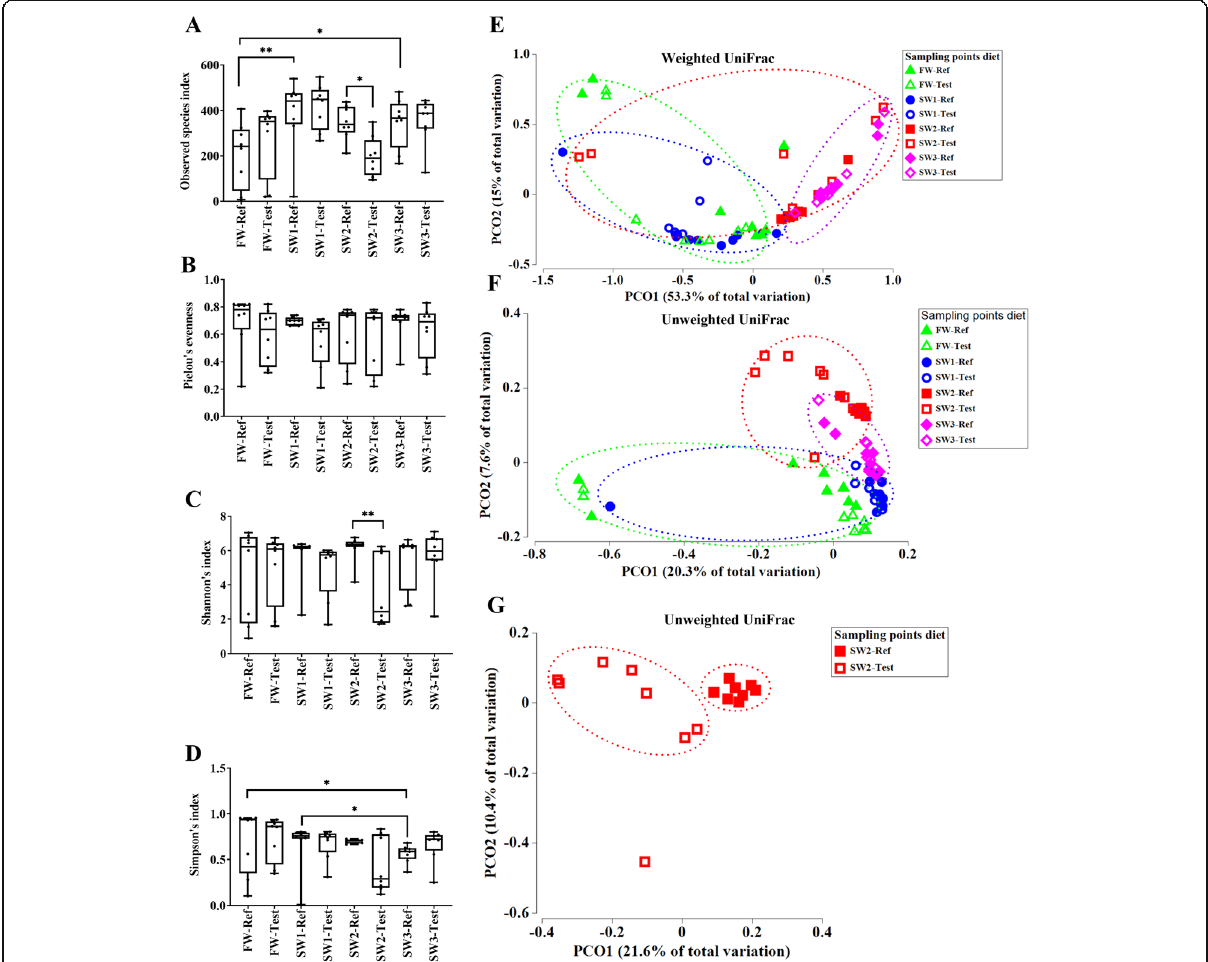
Fig. 1 Alpha diversity and beta diversity of microbiota in digesta from the distal intestine of Atlantic salmon. a Microbial richness in microbiota in digesta from the distal intestine of Atlantic salmon between treatments, as measured using the Observed species index. b Microbial evenness in microbiota in digesta from the distal intestine of Atlantic salmon between treatments, as measured using the Pielou ’ s evenness. c Microbial diversity in microbiota in digesta from the distal intestine of Atlantic salmon between treatments, as measured using the Shannon ’ s index. d Microbial diversity in microbiota in digesta from the distal intestine of Atlantic salmon between treatments, as measured using the Simpson ’ s index. e PCoA plots based on weighted UniFrac show the clustering between treatments. f PCoA plots based unweighted UniFrac show the clustering between treatments. g PCoA plots based on unweighted UniFrac show the clustering of dietary treatment at SW2. For alpha diversity, asterisks indicate significant effect of diet among treatments (* P <0.05, ** P <0.01, n =8). For beta diversity, each dot represents one